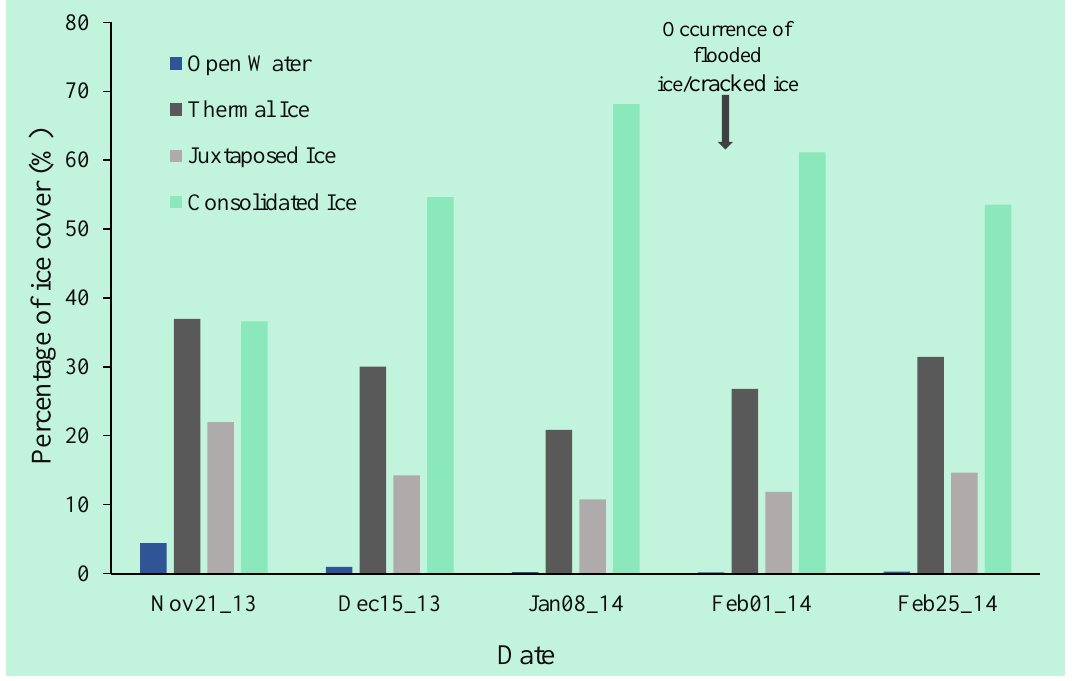
Figure 14. Percentage of ice cover along the Slave River Delta channel in winter